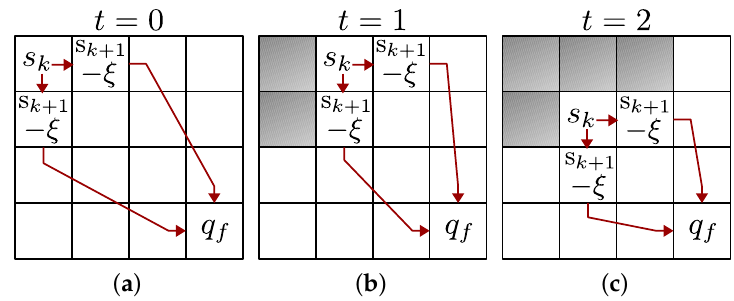
Figure 6. Network structure and state transition. ( a ) state transition t = 0. ( b ) state transition t = 1. (c) state transition t = 2.